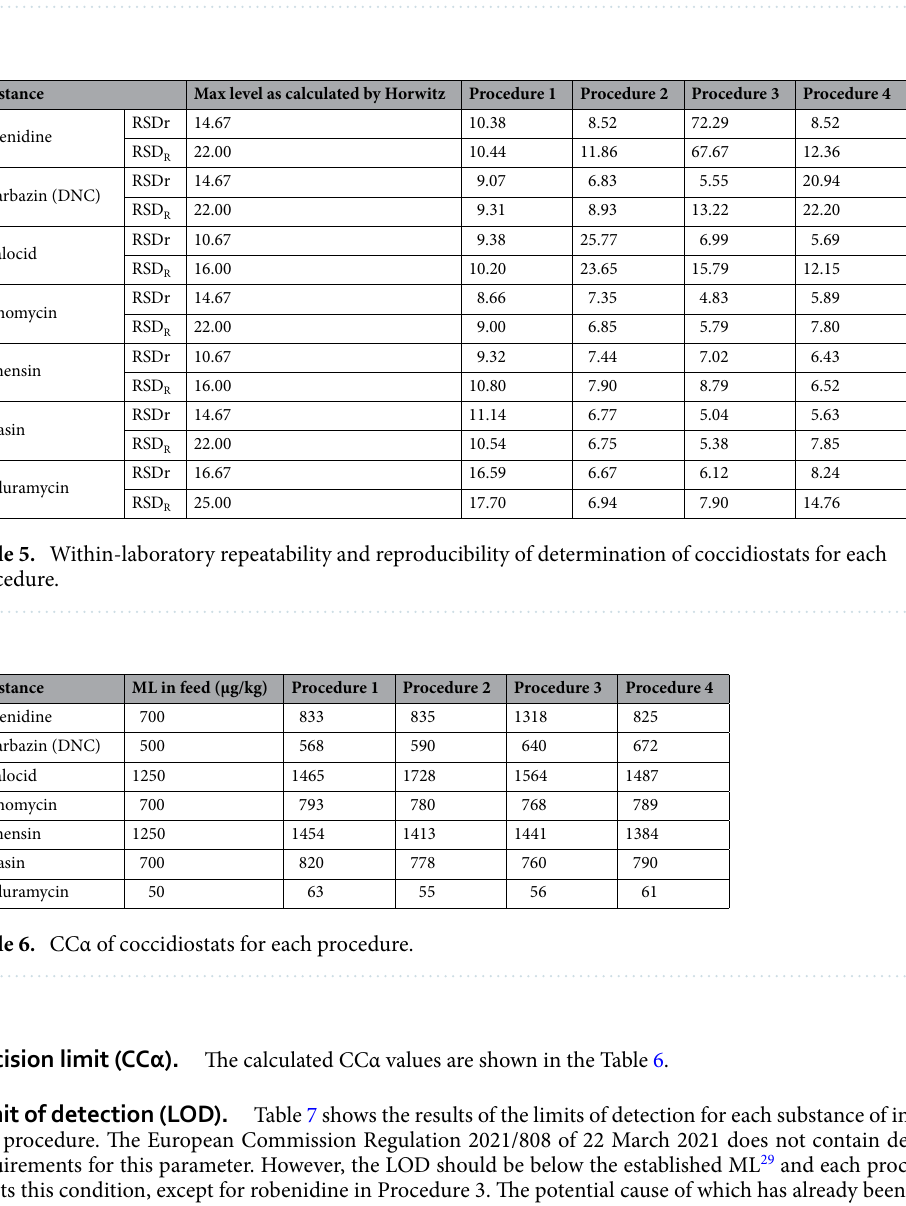
Table 4. Recovery of coccidiostats in samples for each procedure.